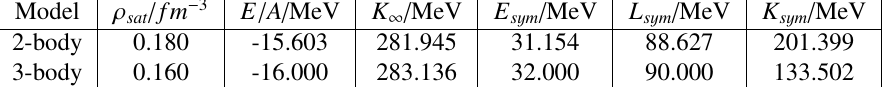
8 λ a B a , a = 1 √ 2 (cid:1) 8 λ a V a a = 1 √ 2 (cid:1)